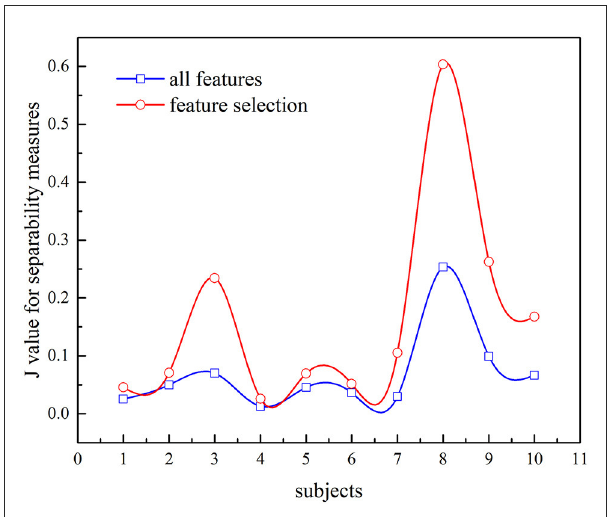
FIGURE10 Comparison of J F values between all features and feature selection for k-complex detection.